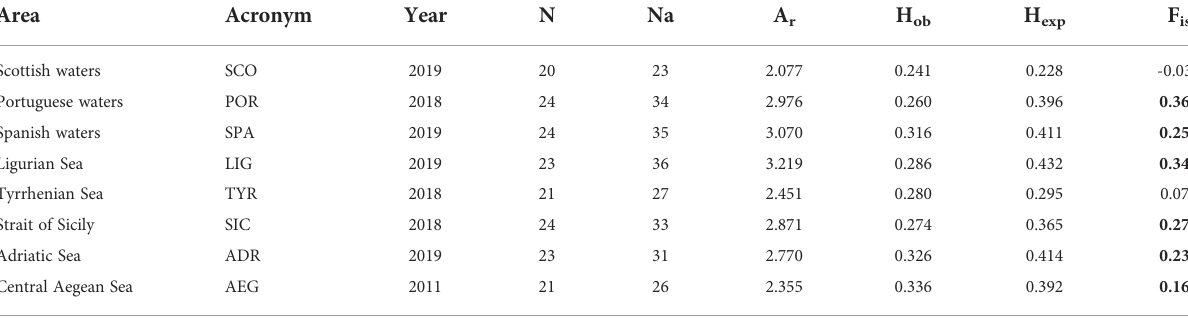
TABLE 1 Sampling summary and main genetic diversity statistics of Galeus melastomus geographical samples. Area